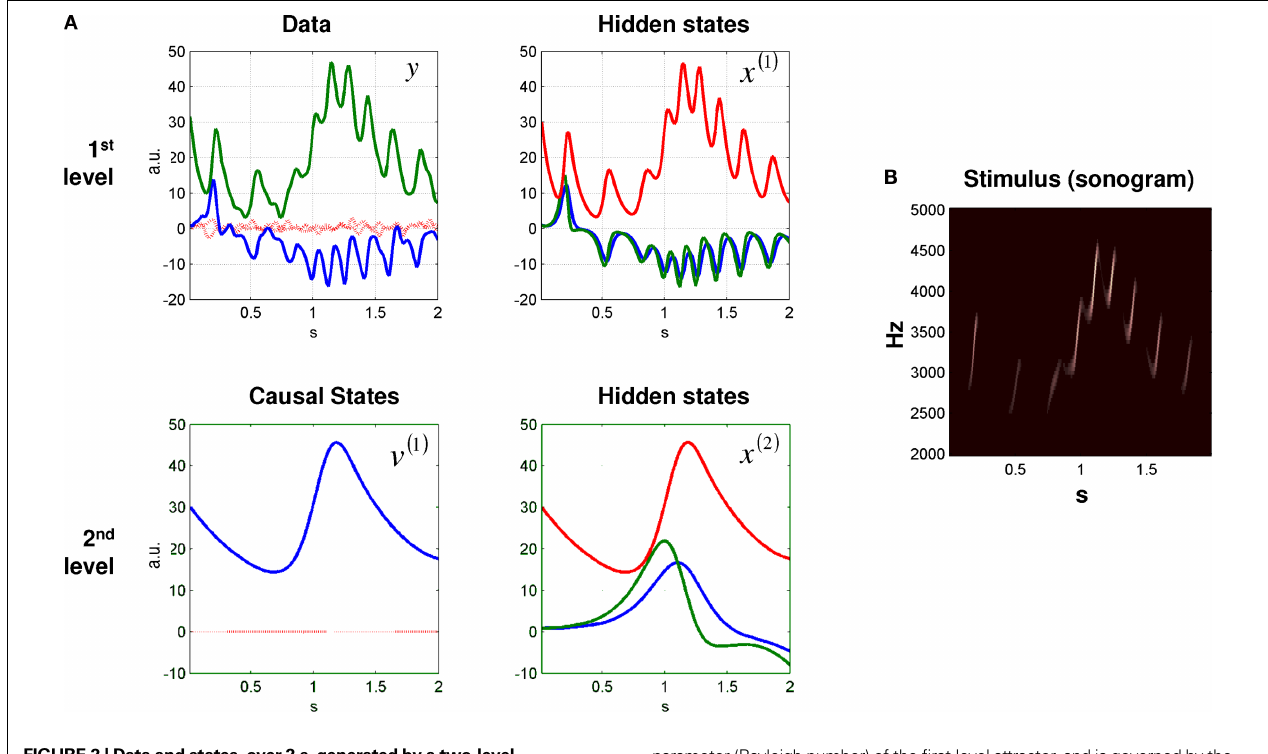
parameter (Rayleigh number) of the fi rst-level attractor, and is governed by the hidden states at the second level (right: blue, green, and red solid line). The red dotted lines (top left) indicate the observation error on the output. (B) Sonogram (time-frequency representation) constructed from model output. High intensities represent time-frequency locations with greater